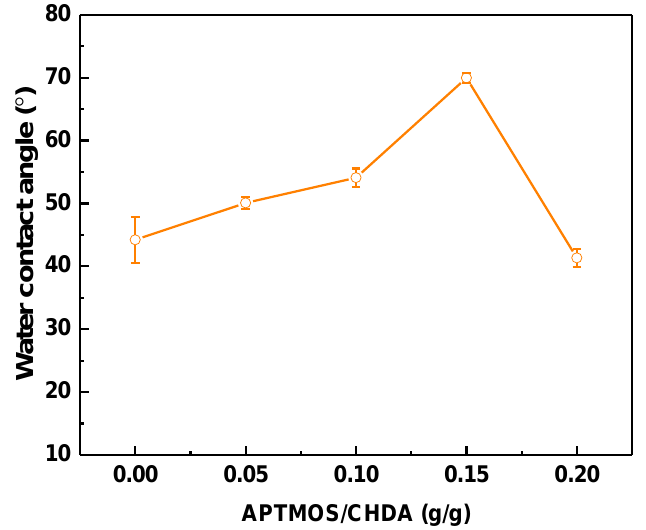
Figure 5. Water contact angles of various TFN membranes, depending on the ratio of APTMOS to CHDA.